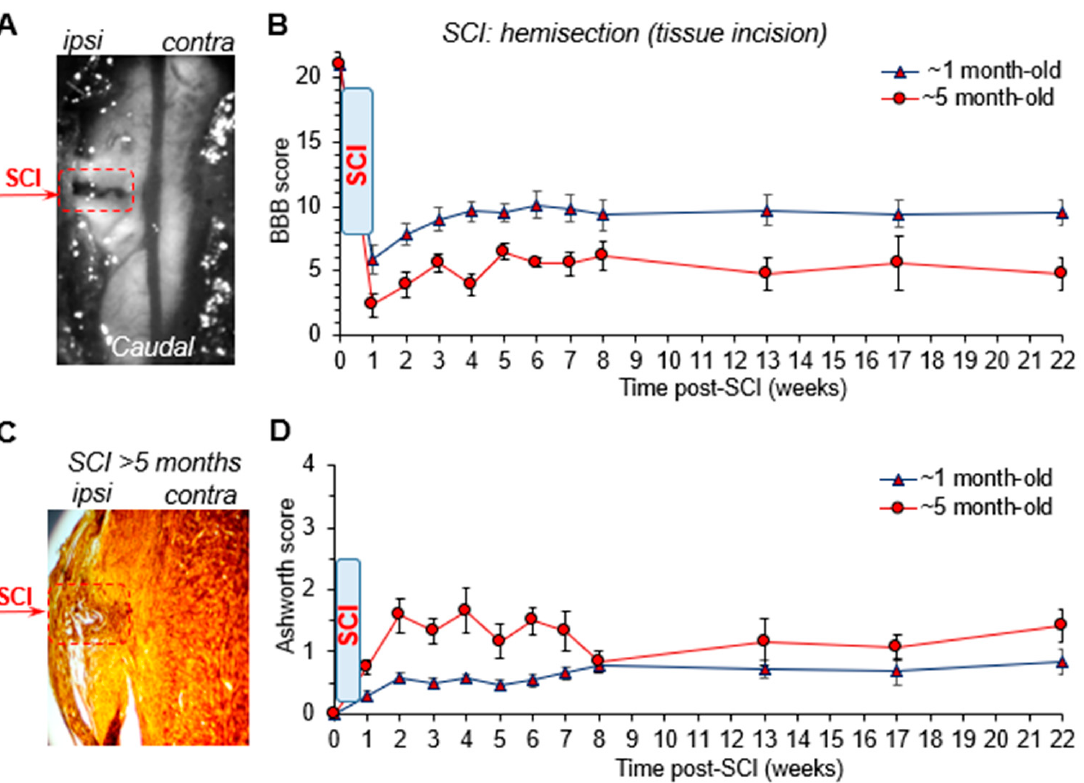
Figure 2. The motor deficit recovery depends on the age at the time of injury. ( A ) A transmitted light image of the spinal cord region, which was subjected to an arguably mild experimental SCI—hemisection with tissue incision. Red dashed line denotes the lesion area. ( B ) The time-course of the motor function on the ipsilateral to injury side (the BBB score) in rats of different ages at the time of injury. ( C ) Image of hematoxylin-eosin staining of the transverse spinal cord tissue at the hemisection region at 5 months after SCI. ( D ) The time-course of muscle tone on the ipsilateral to injury side assessed with the Ashworth scale in young and older SCI rats (same groups as in ( B )). Data are mean ± SEM.